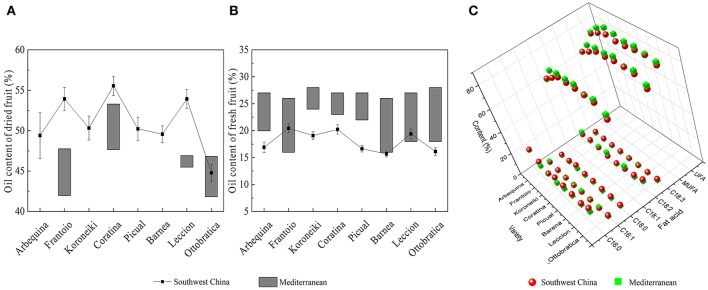
The oil content and fatty acids composition of olives from southwest China and the Mediterranean region. (A) Dried fruit oil content (B) Fresh fruit oil content (C) Fatty acids composition of olive oil. The data of Mediterranean olive are from the olive database.